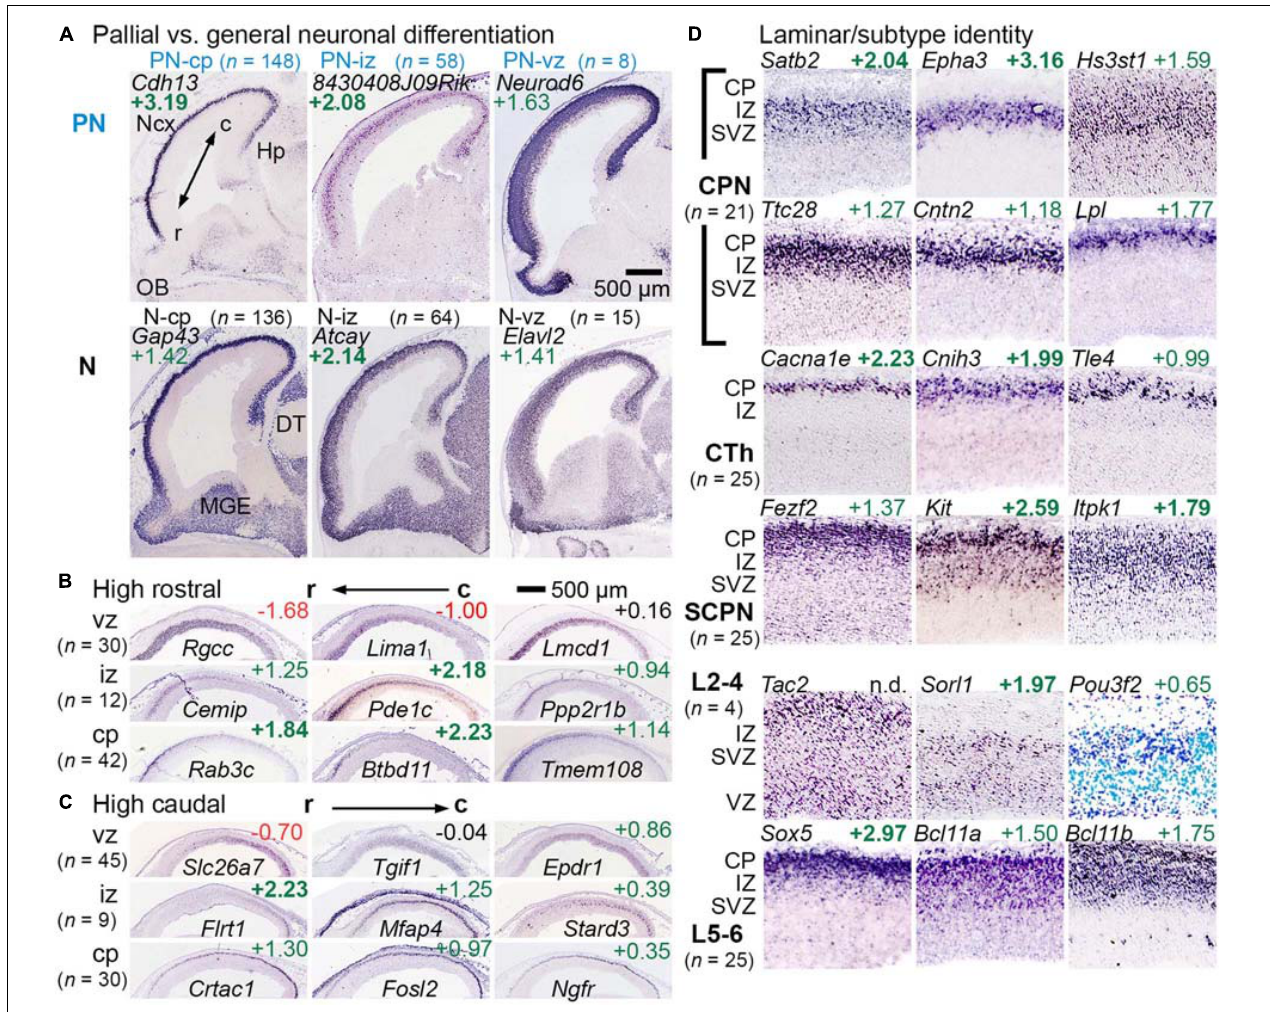
FIGURE 2 | Gene sets for regional, laminar, and axonal projection identity or fate. (A) Genes that were expressed mainly in pallium but not ventral forebrain were categorized as PN genes, while genes expressed widely expressed in differentiation zones were categorized as general neuronal (N). PN and N genes were found in each histologic zone, categorized according to the deepest zone of expression. Not shown: PN-svz ( n = 14) and N-svz ( n = 48). R-C indicates the rostrocaudal axis. (B,C) Rostrocaudal expression gradients were typically found within 1–2 contiguous zones. (D) Genes linked to specific laminar and axonal projection fates were categorized (see section “Materials and Methods”). Abbreviations: CPN, callosal projection neuron; CTh, corticothalamic; SCPN, subcerebral projection neuron. n.d., not